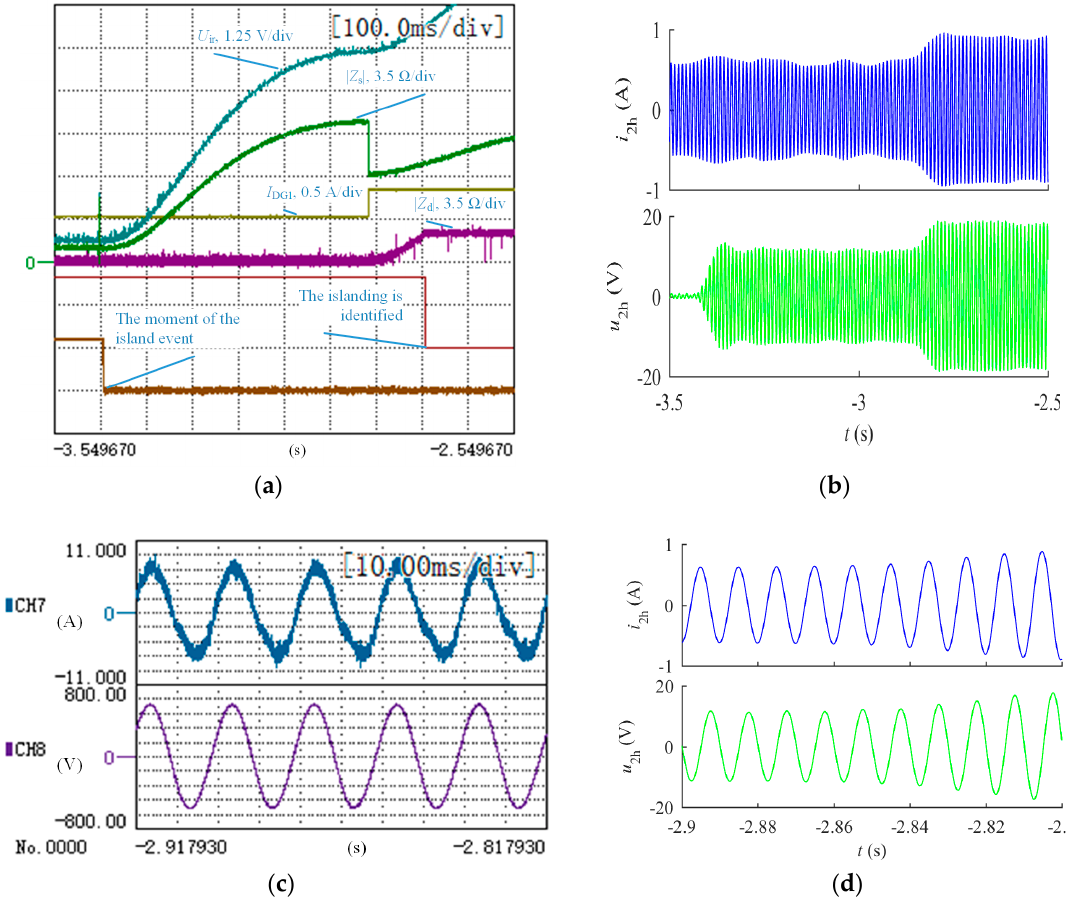
Figure 10. Island event occurring and the related waveforms of current and voltage. ( a ) The whole process of the islanding detection; ( b ) Waveforms of the second harmonic current and voltage during the islanding detection; ( c ) Measured current and voltage before and after the change of I DG1 ; ( d ) Waveforms of the second harmonic current and voltage contained in the measured current and voltage shown in ( c ). CH7: the measured current; CH8: the measured phase-to-phase voltage; i 2h : the second harmonic current; u 2h : the second harmonic voltage. Theoretically, the amplitude of u 2h √ (phase-to-phase voltage) is 3 times the U ir (phase-to-ground voltage) in ( a ).